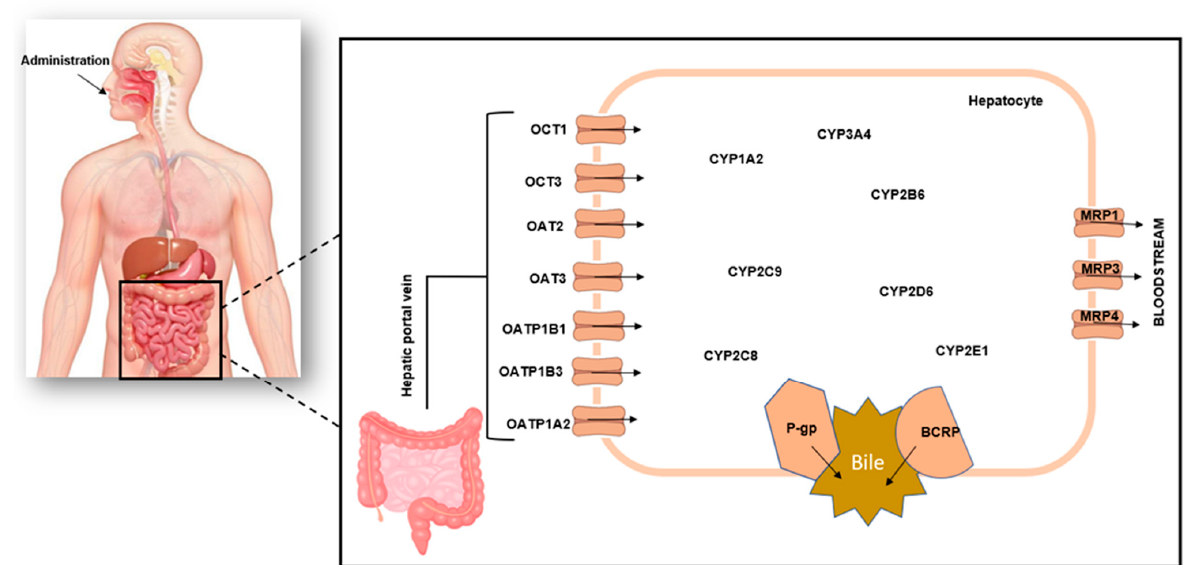
Figure 1. Schematic representation of hepatic drug metabolism. Orally administered drugs pass through the gastrointestinal tract to the intestines where absorption occurs and go to the liver via the hepatic portal vein, and this movement is facilitated by various drug transporters. Drug metabolism primarily takes place in the liver, but it can also happen in other organs such as the lungs, intestines, kidneys, blood, skin, and adrenals. In the liver, drugs are metabolized by cytochrome P450 enzymes. Once they have been metabolized, they enter the enterohepatic recirculation via the bile duct.